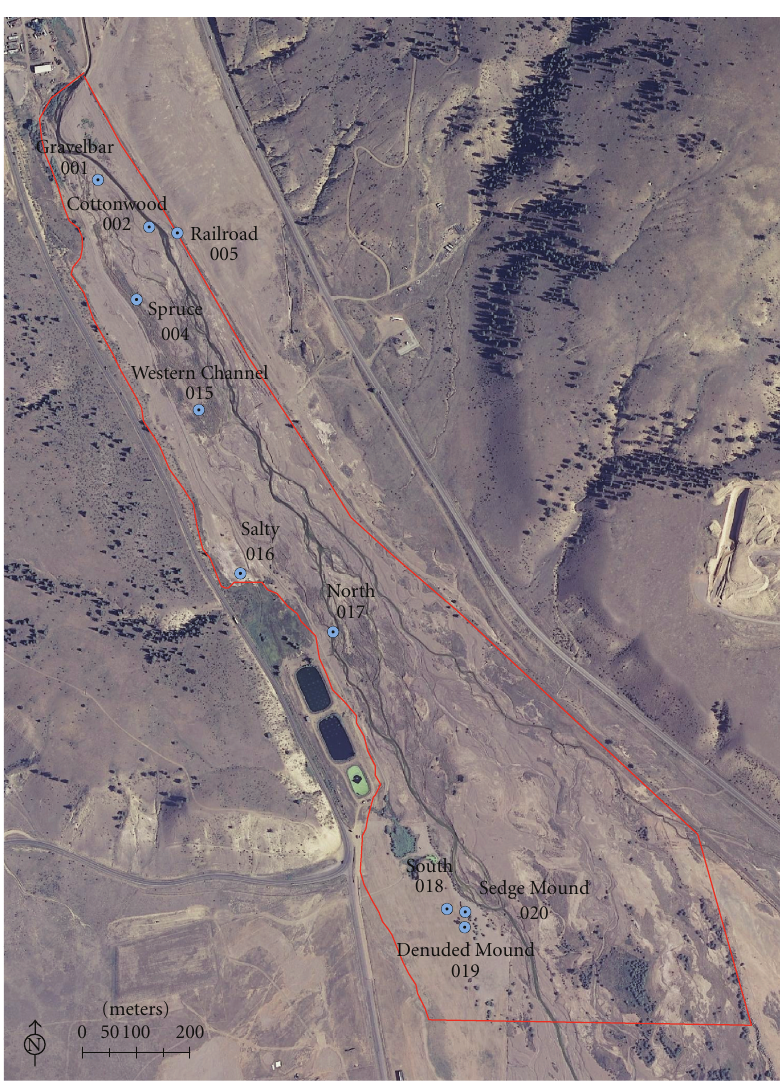
Figure 2: Willow Creek floodplain showing soil sample sites.